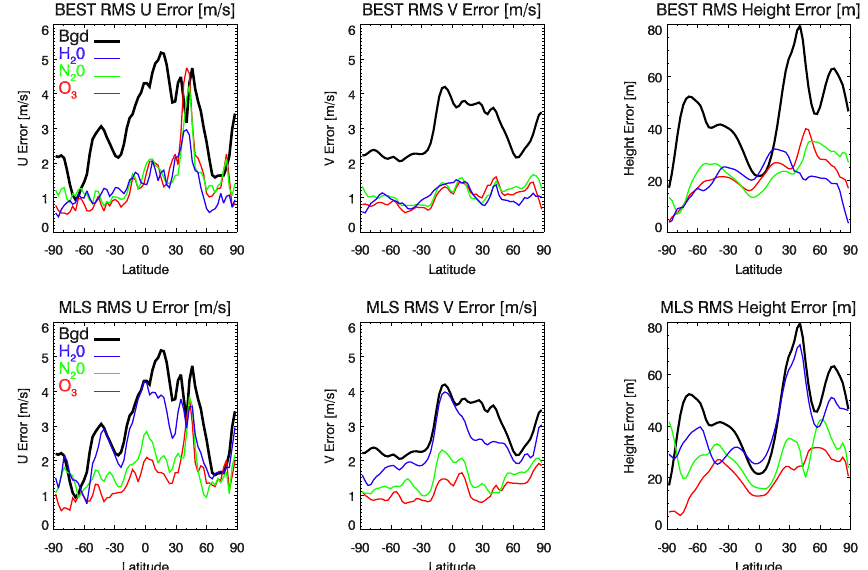
Fig. 4. RMSE for zonal wind, meridional wind, and height as a function of latitude for the first cycle of the BEST experiment (top row panels) and MLS experiment (bottom row panels) at t =0h. Background errors are black, while analysis errors are shown for O 3 (red), N 2 O (green), and H 2 O (blue). Units are ms − 1 for zonal and meridional wind and m for